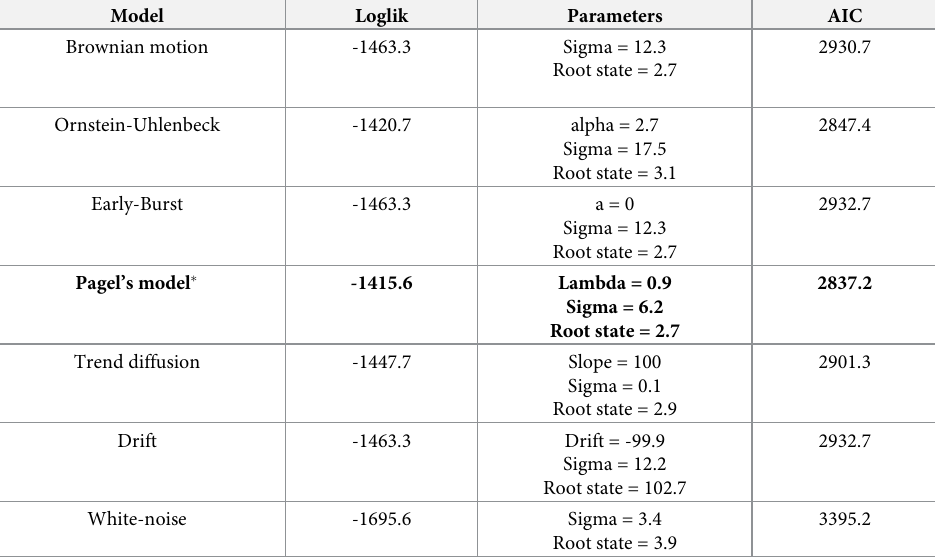
Table 1. Summary of model fitting for genome size data. We highlighted the model that showed the highest likeli- hood and the lowest